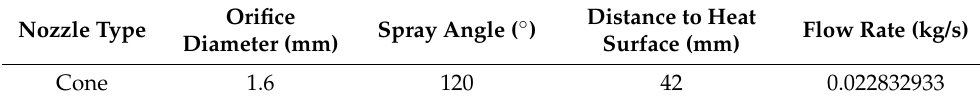
Table 1. Characteristics of spray nozzle in test